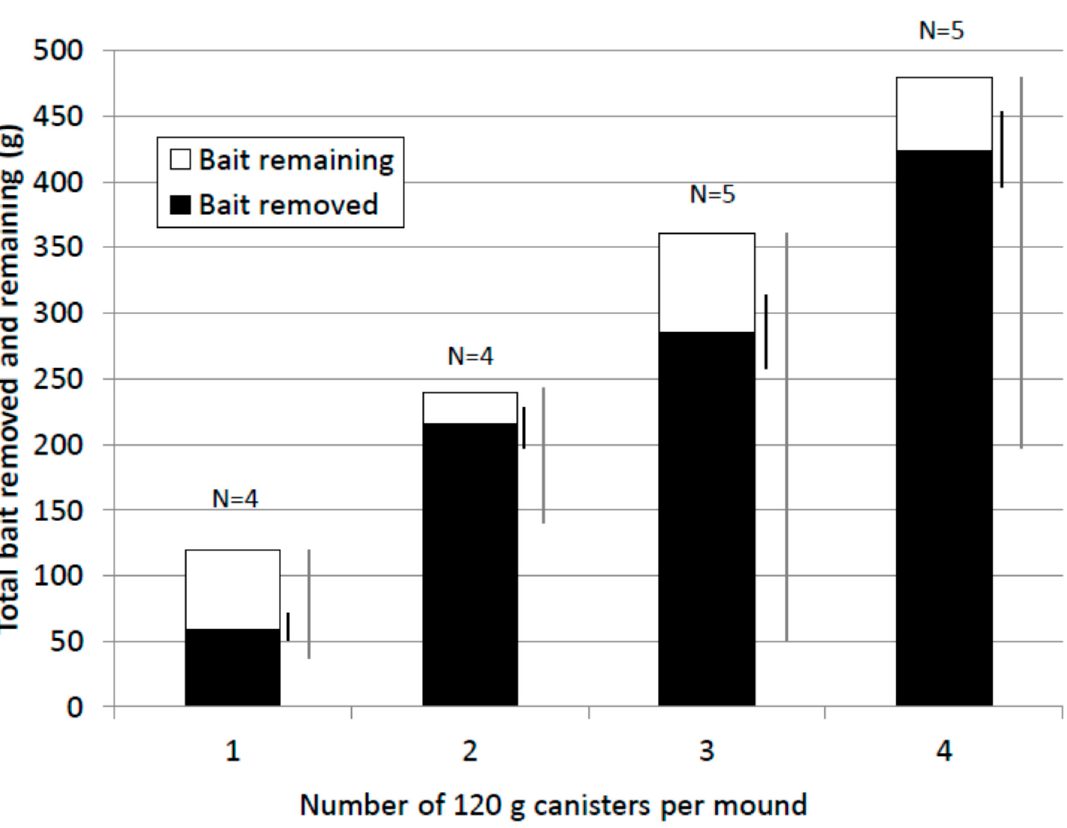
Figure 6. Mean bait removed by termites and bait remaining (grams). Standard Error (SEM) (black) and range bars (grey) for bait removed are shown to the right of each treatment column.